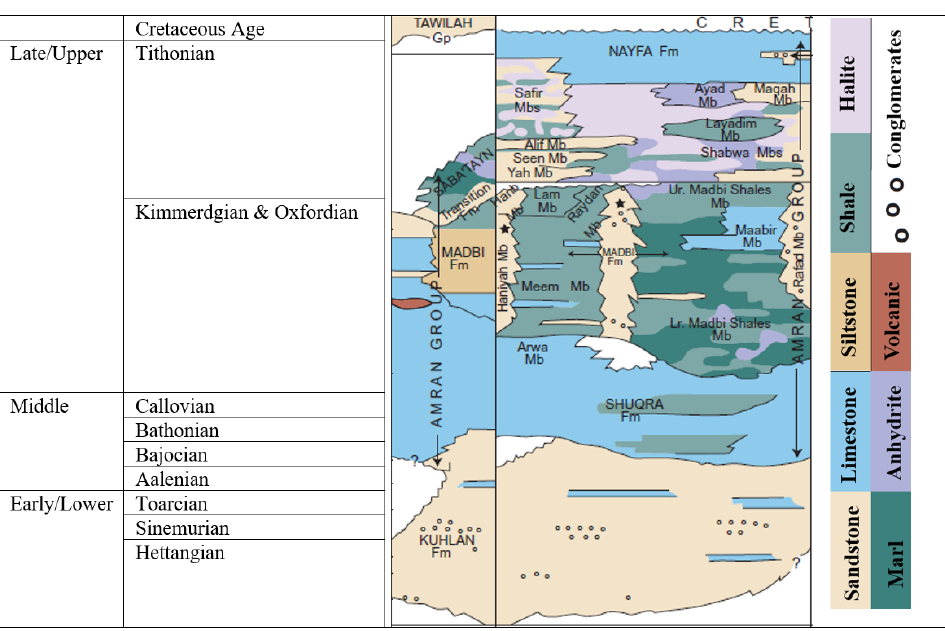
Figure 3. The Quaternary aquifer’s groundwater fl ow direction. 2.3. Water Sampling and Analysis The groundwater samples, totaling 27, were collected from wells and boreholes lo- cated throughout the Quaternary Aquifer in the Al-Jawf region. Non-acidi fi ed water sam- ples were collected and stored in approximately 1.5 dm 3 polyethylene bo tt les, which were then kept at 4 °C. The chemical composition of the water was analyzed to determine the presence of Mg 2+ , Ca 2+ , K + , Na + , SO 42 − , HCO 3 − , Cl − , and NO 3 − . The ionic balance (IB) was calculated as a percentage di ff erence between the total amount of positively charged ions (cations) and negatively charged ions (anions) present in water using the following for- mula (Equation (1)): IB = (TC − TA)/(TC + TA) × 100 (1) where TC represents the total amount of cations and TA represents the total amount of anions, both measured in milliequivalents per liter. To con fi rm the assessment of water quality, an acceptable range for IB is within ±5 [50].